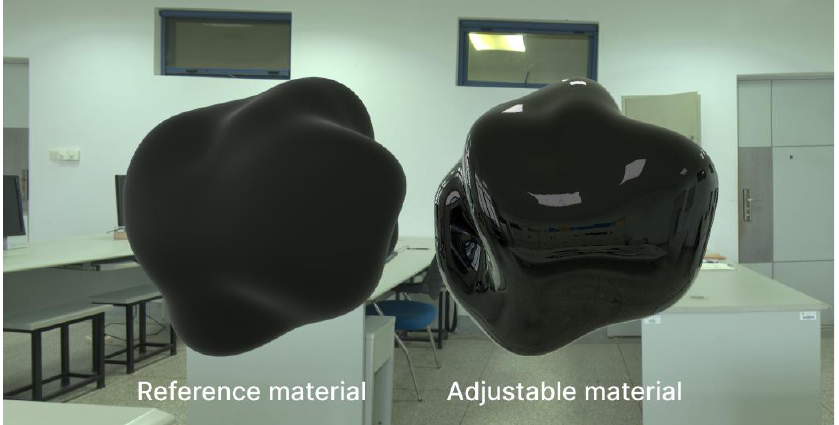
Figure 5. The stimuli presented to the participants in VR during Experiment 2: a natural block model with an irregular shape. This model is generated by using random Perlin noise to perturb the radial displacement of the spherical vertices in Blender. The left side of the screen displayed a material stimulus used for reference, while the right side displayed stimuli that the users could adjust.